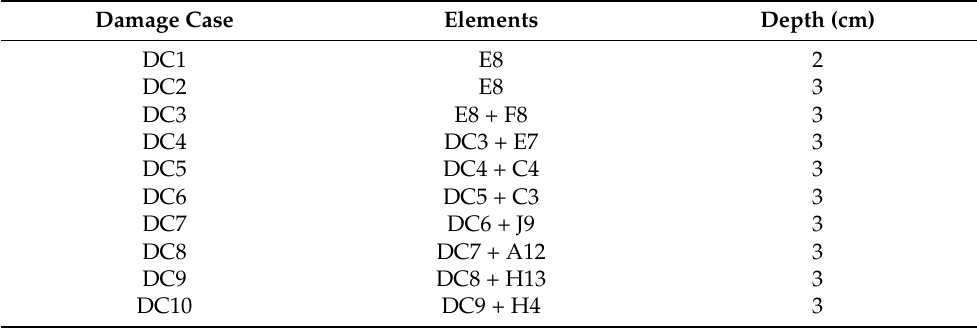
Table 1. Damage cases simulated on the concrete plate.